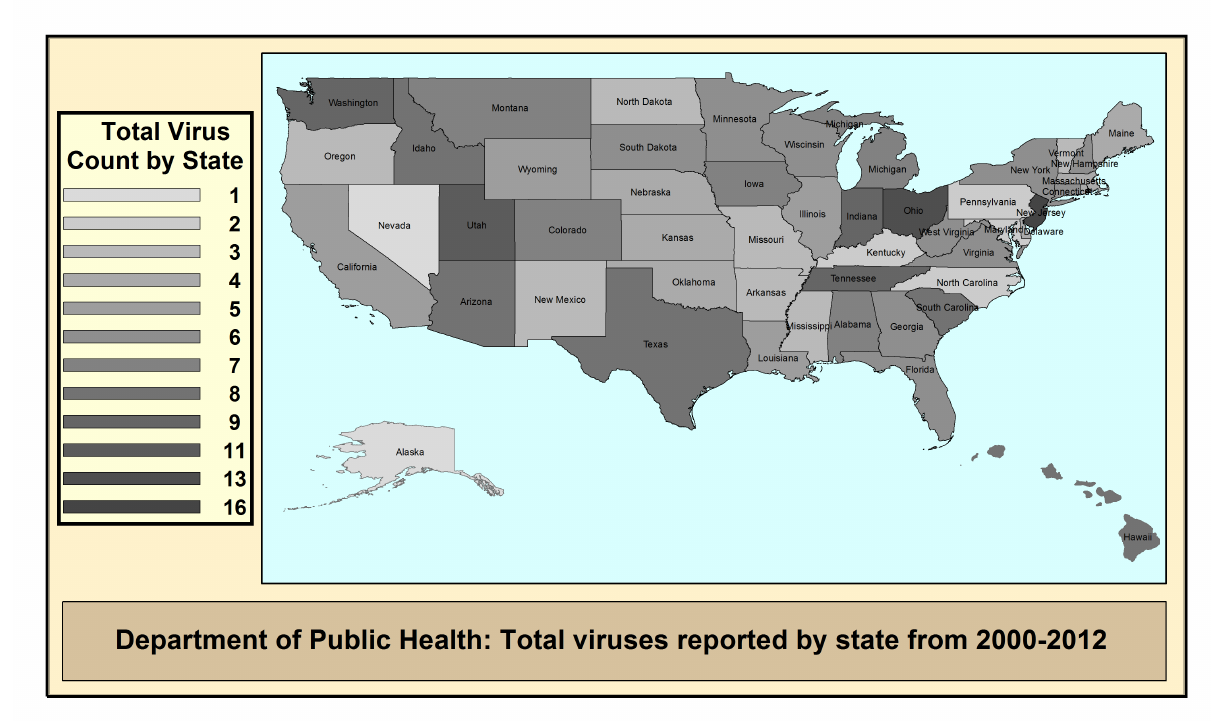
Figure 3. Map of the number of online virus data at public health departments (theoretical maximum: 63